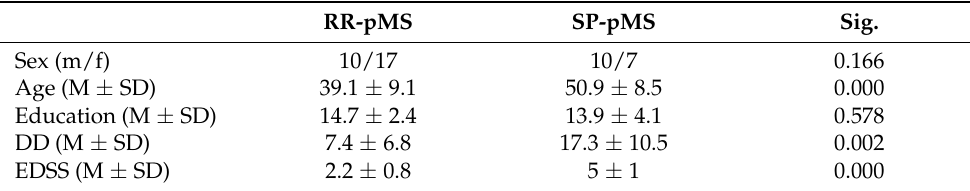
Table 1. Clinical and demographic data of the MS